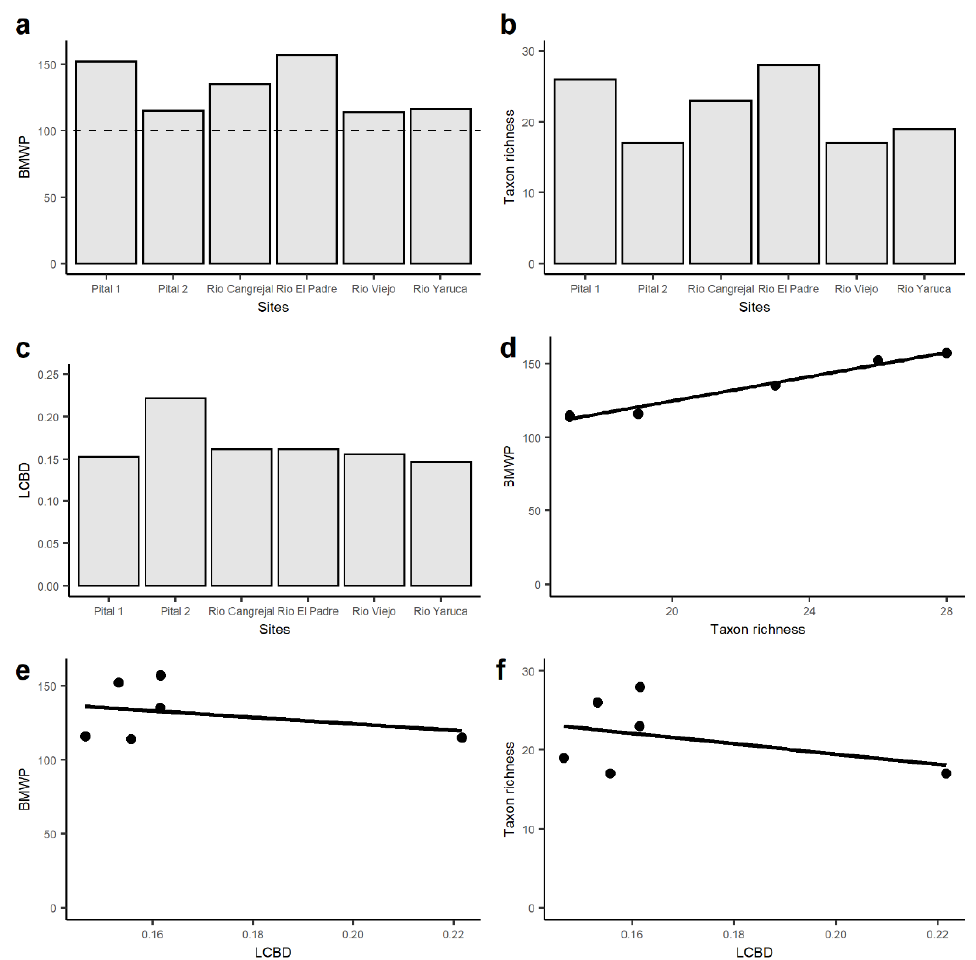
Figure 2. Gray bars represent the following: ( a ) BMWP score, ( b ) total taxon richness, and ( c ) LCBD in all sampling sites. The dashed horizontal line in figure ( a ) indicates the limit between the class I and class II water quality classes, according to the BMWP methodology [20]. ( d ) Correlation between the BMWP and taxon richness; ( e ) correlation between the BMWP and LCBD; ( f ) correlation between the taxon richness and LCBD.